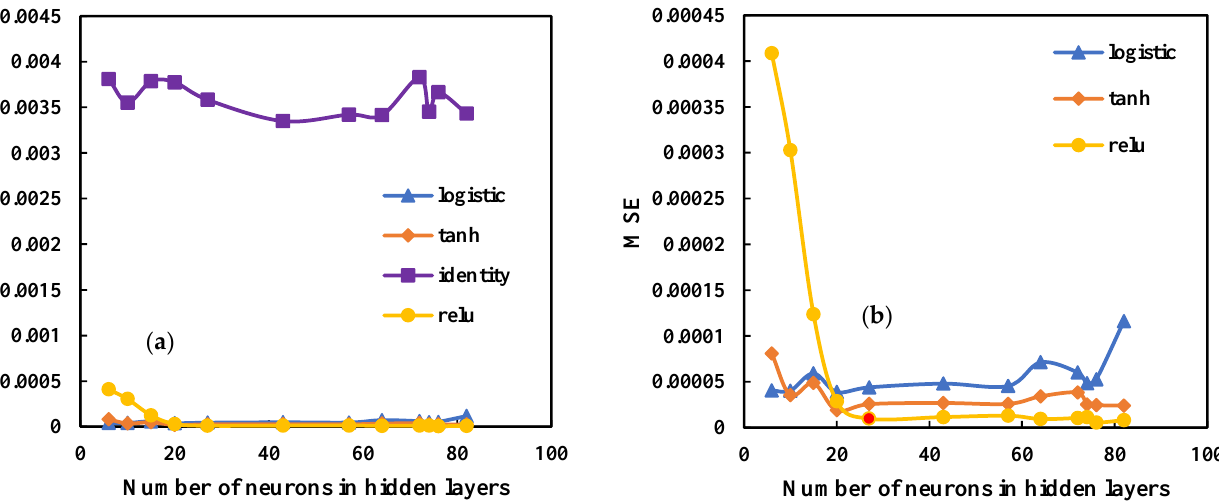
Figure 9. Comparison between different activation functions to find best function in MLP network ( a ) comparison of four activation functions; ( b ) comparison of three activation function.